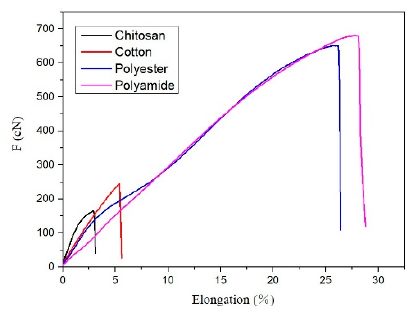
Figure 5. The breaking strength of four yarns.